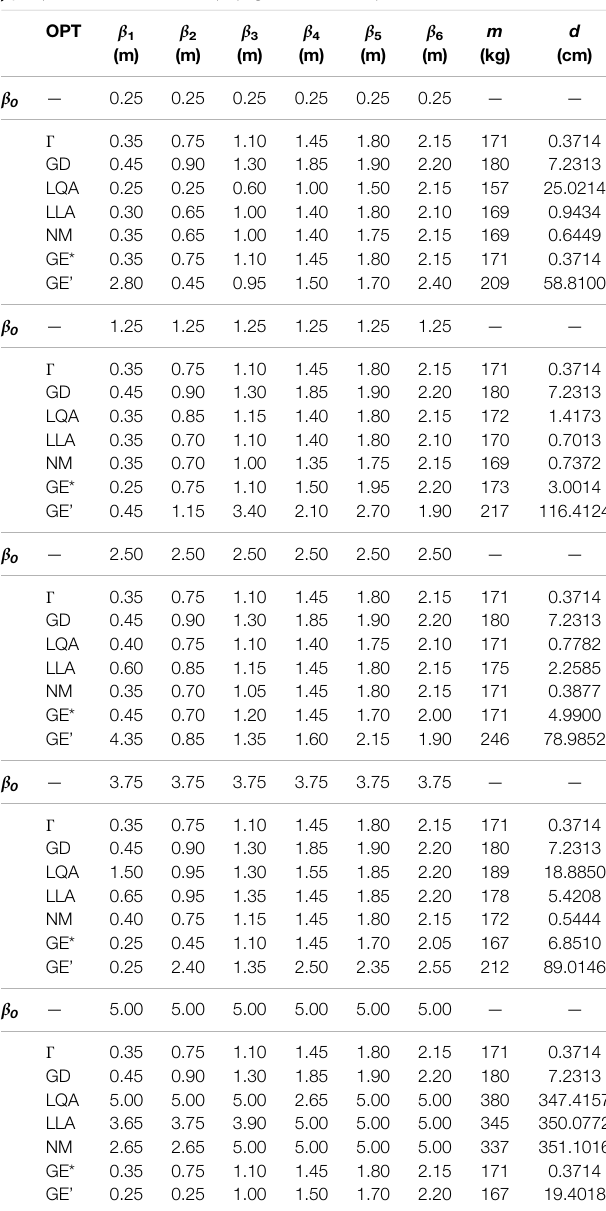
TABLE2| Resultsofparameters β 1 , ... , β 6 fordifferentinitial β 0 ( Figure8 ),mass m ( Eq. 6 ), and deformation d ( Eq. 5 ) of optimization algorithms OPT with maximum run-time of that needed by the Γ operator ( Figure 1A ) as early stop criterion for each β 0 ; GOAT algorithms ( Figure 3 ): GD = global deterministic (DIRECT), LQA = local quadratic approximation (BOBYQA), LLA = local linear approximation (COBYLA), NM = Nelder – Mead (SUBPLEX), GE* and GE ’ = global evolutionary best* and worst ’ result of 5 runs; visualization of results for β 0 = (2.5 2.5 2.5 2.5 2.5 2.5) T ( Figures 8E , 9A,C